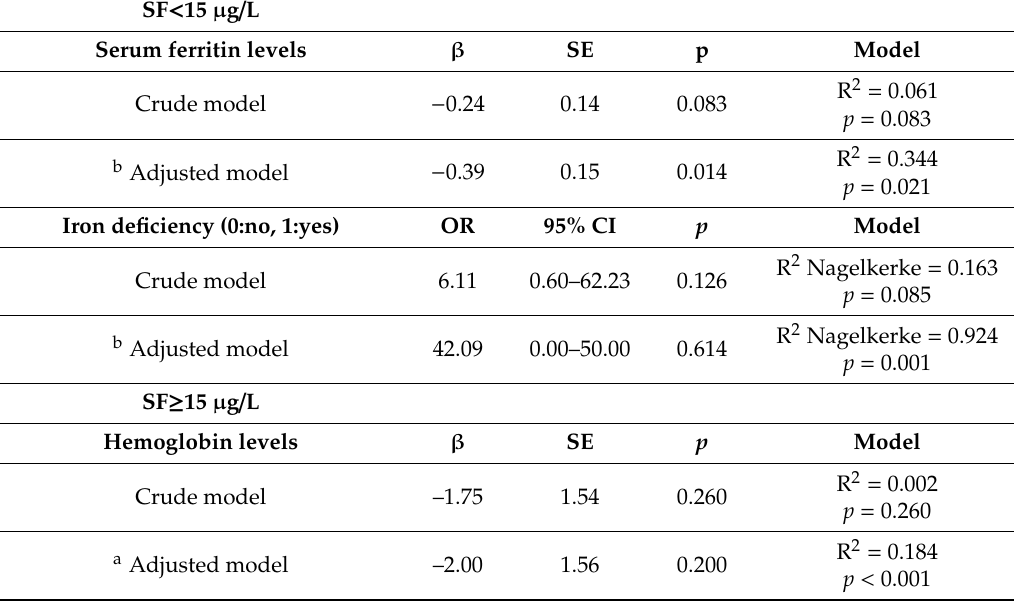
Table 6. The e ff ect of the intervention with iron supplementation on Stratum 2 (0:40 mg / d, 1:20 mg / d) throughout pregnancy regarding maternal iron status in the third trimester, according to initial iron